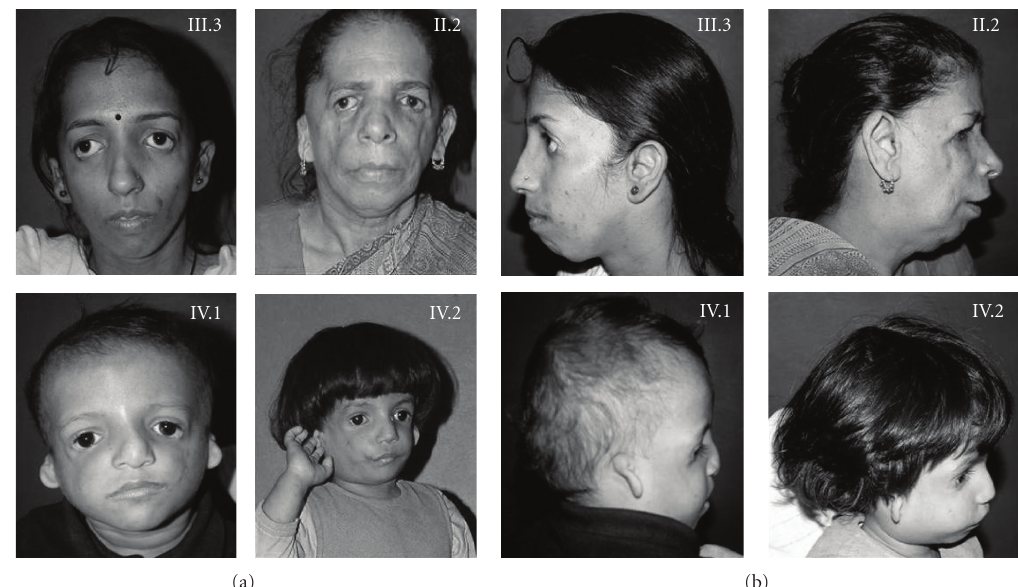
Figure 2: (a) Showing the phenotypes of the e ff ected members (front view). (b) Showing the phenotypes of the e ff ected members (side view).